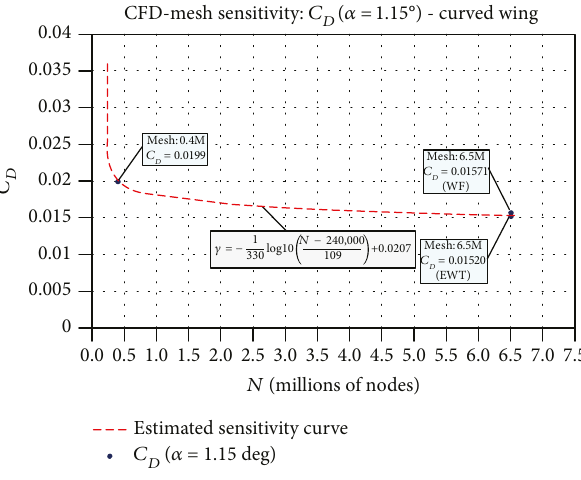
Figure 15: CFD mesh sensitivity — C